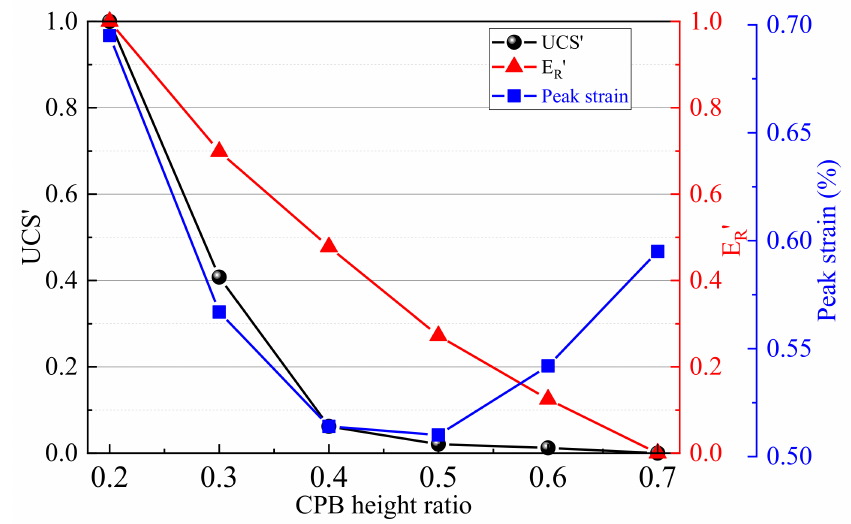
Figure 15. Composite diagram of CPB height ratio, ( UCS ’, E R ’, and peak